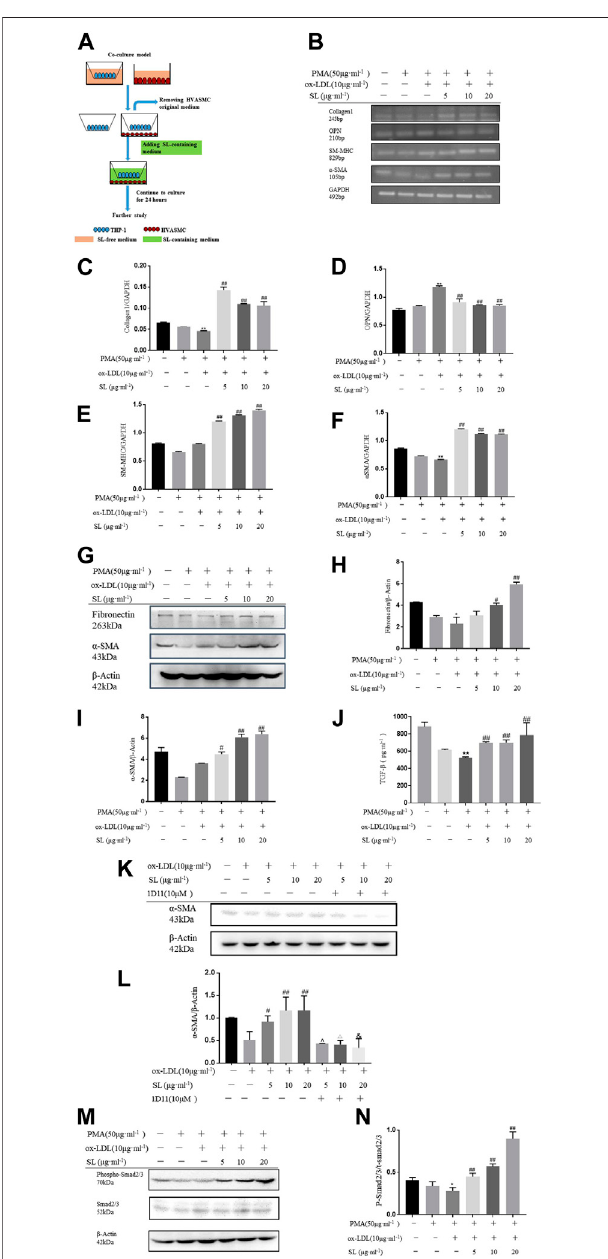
FIGURE 3 | SLincreasesSMCscontractilephenotypeinmacrophage/SMC co-culture model. (A) In vitro , the protocol of co-culture model for ef fi cacy identi fi cation of SL. (B – F) RT-PCR assay for ECM related marker (Collagen1), synthetic SMCs related markers (OPN), contractile SMCs related markers (SM-MHC, α -SMA) in HVASMCs from macrophage/SMCs co-culture model (G – I) DetectionoftheproteinexpressionofFibronectin, α